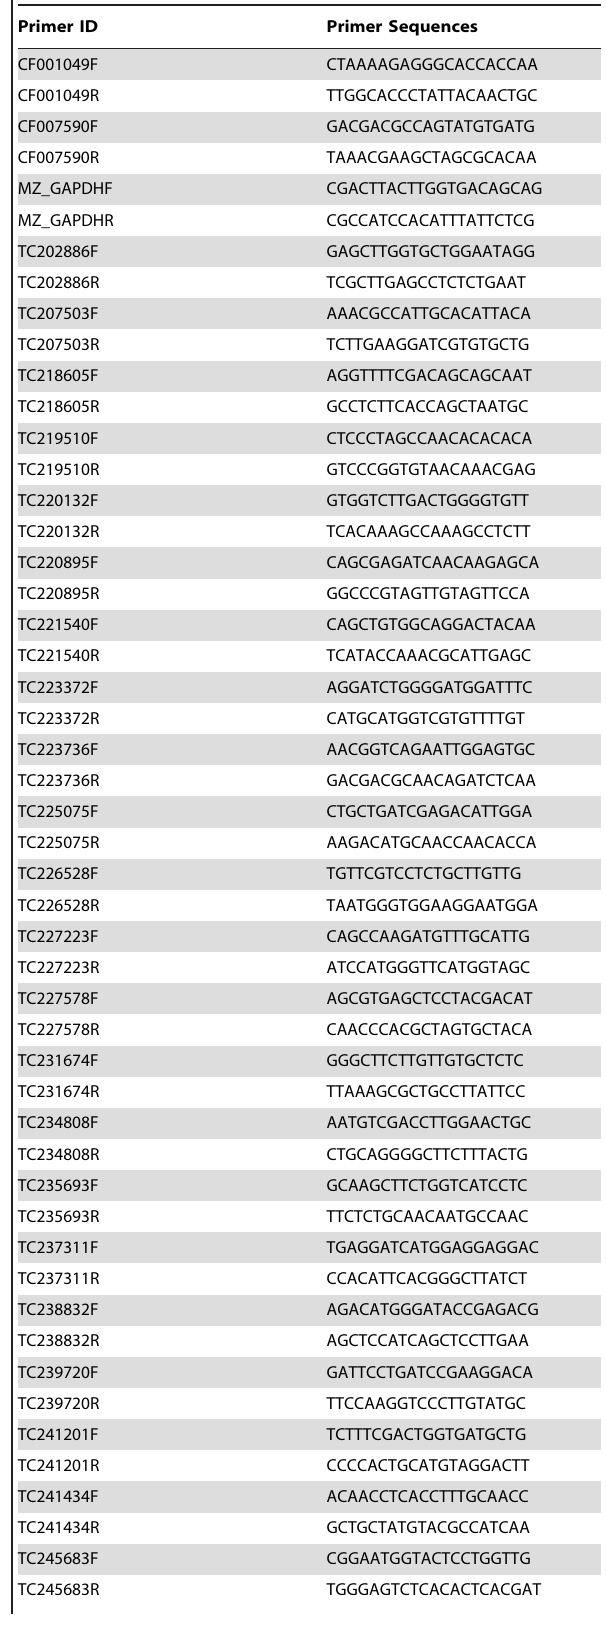
Table 2. Primer sequences of candidate genes and the house keeping gene GAPDH in qRT-PCR study.